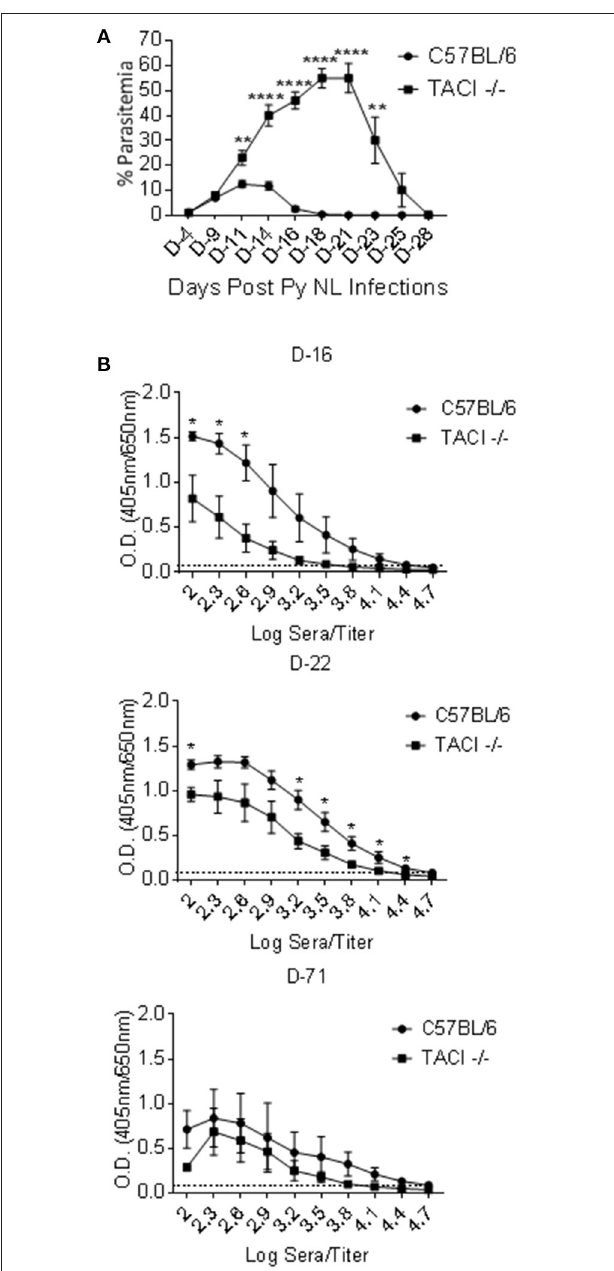
FIGURE 1 | P. yoelii infection clearance and antibody development are delayed in TACI -/- mice. (A) TACI -/- and C57BL/6 mice were infected (i.p.) with 1 × 10 6 P. yoelii (Py 17XNL) parasites. Parasitemia levels were evaluated by blood smears at indicated days post challenge until parasitemia clearance. Results are expressed as mean % parasitemia ± SEM for 10 mice per group. One representative experiment out of three with similar infection outcome is shown. (B) TACI -/- and C57BL/6 mice (9 per group) were infected (i.p.) with 1 × 10 6 P. yoelii parasites. Individual serum was collected from three mice of each group (per time point) on days 16, 22, and 71 post parasite challenge and were tested in ELISA for anti-rMSP-1 19 IgG antibody measurement (Please see Supplementary Figure 1A for days 8 and 28 ELISA results). Average OD values ± SEM from three samples on each time point were plotted. Dotted line indicates ELISA negative control. Unpaired student’s t -test was used for statistical evaluation. *indicates p < 0.05, ** < 0.01; **** p < 0.0001. Experiment was performed